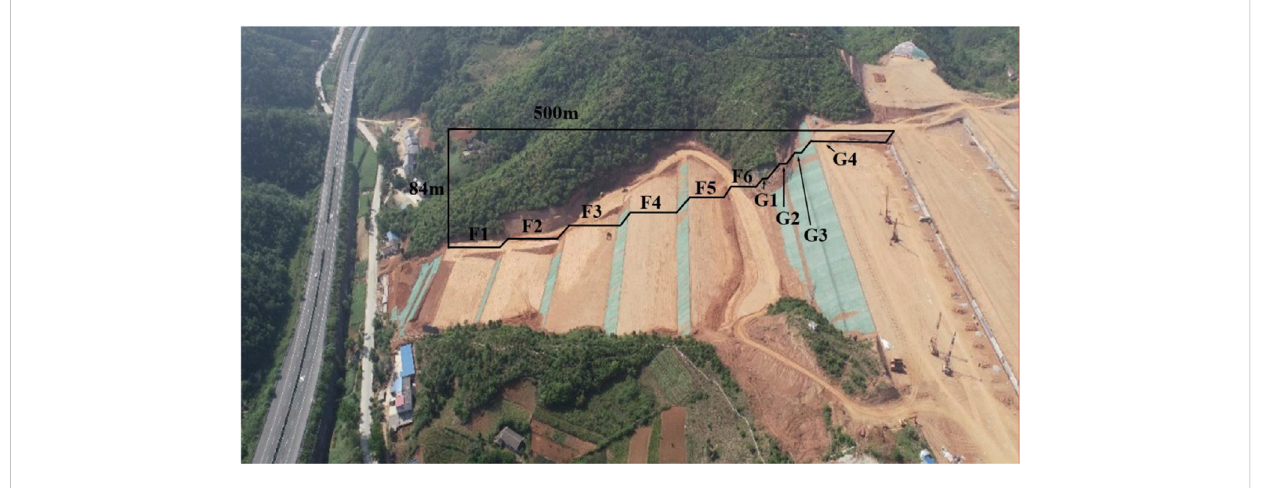
FIGURE 3 F and G area of the Alleviation Industrial